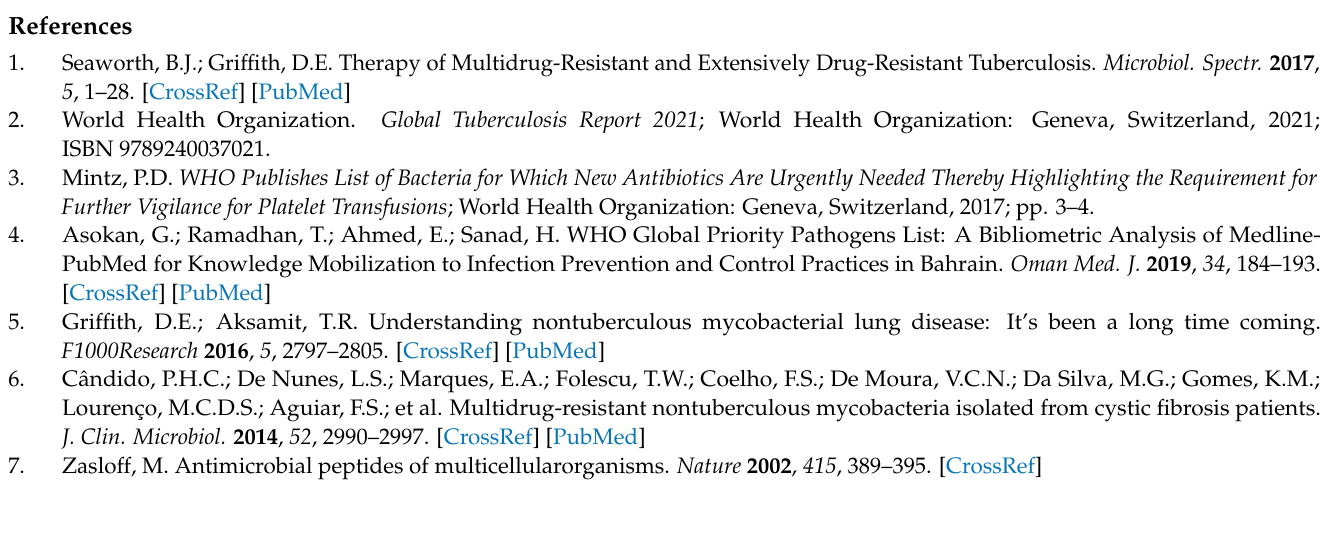
Figure S1: HPLC chromatogram of levulinyl-PEP ; Figure S2: HPLC chromatogram of azido-PEP ; Figure S3: HPLC chromatogram of F-PEP ; Figure S4: HPLC chromatogram of ValCit-PEP ; Figure S5: HPLC chromatogram of LAAG-PEP ; Figure S6: HPLC chromatogram of GFLG-PEP ; Figure S7: The course of the copper-free Strain-Promoted Alkyne-Azide click reaction of azido-PEP to the polymer precursor 2 ; Figure S8: MS-ESI spectra of levulinyl-PEP ; Figure S9: MS-ESI spectra of azido-PEP ; Figure S10: MALDI-TOF spectra of F-PEP ; Figure S11: MS-ESI spectra of ValCit-PEP ; Figure